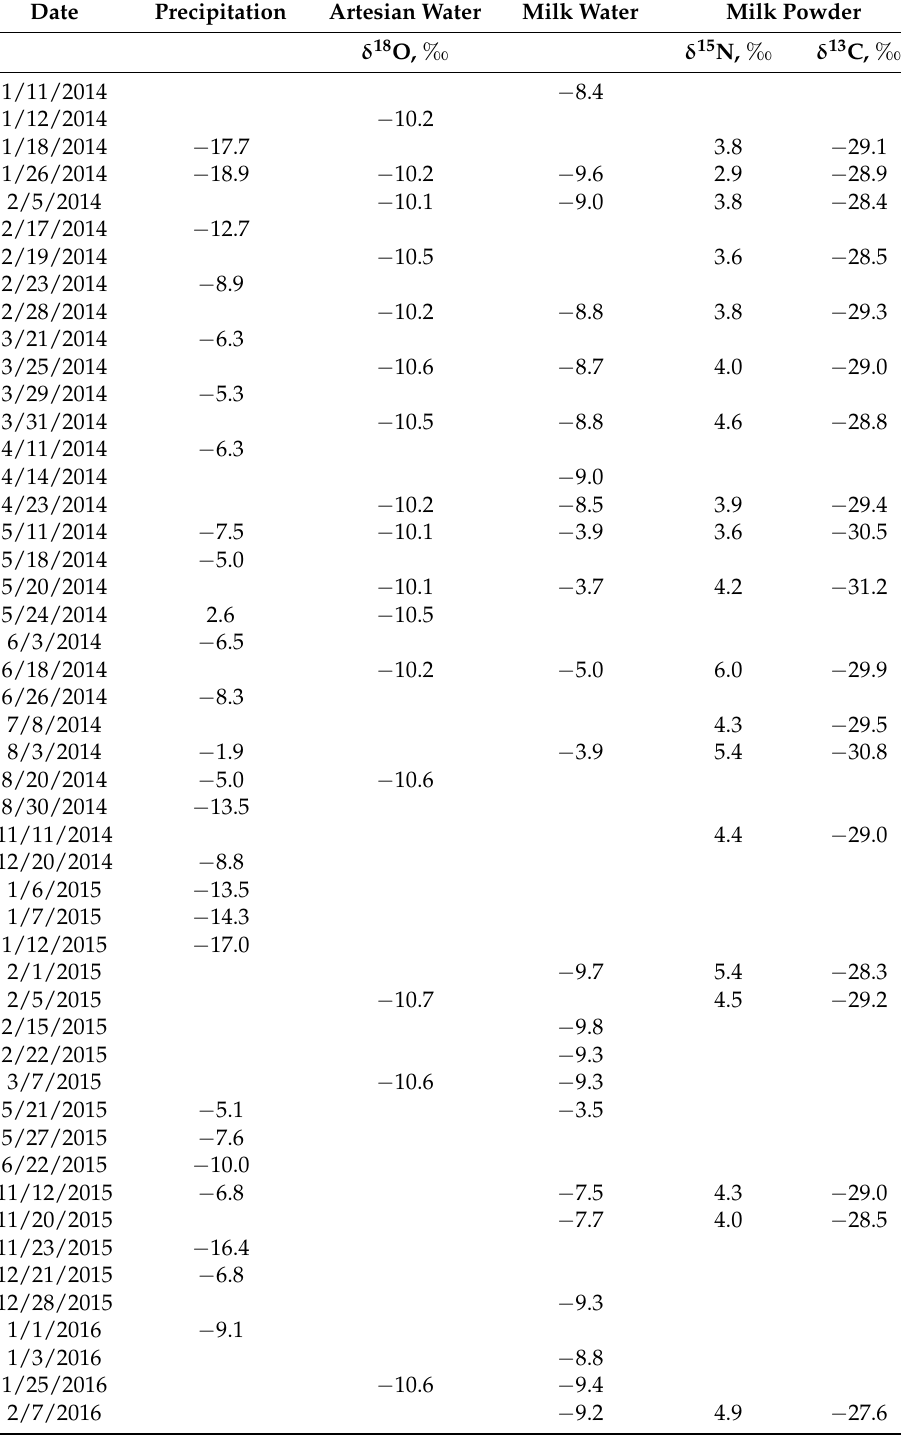
Table A1. Stable isotope ratio values for the measured samples. δ 18 O was measured in precipitation, artesian water, and milk water, while δ 15 N and δ 13 C were measured in dried milk powder. Milk was collected from the same